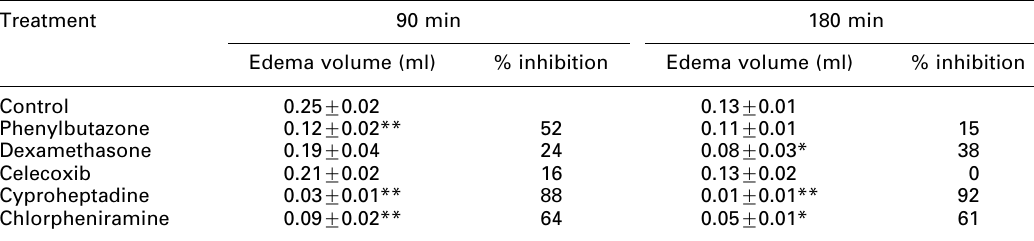
The edema volume was measured at 90 and 180 min. * p B / 0.05, ** p B /